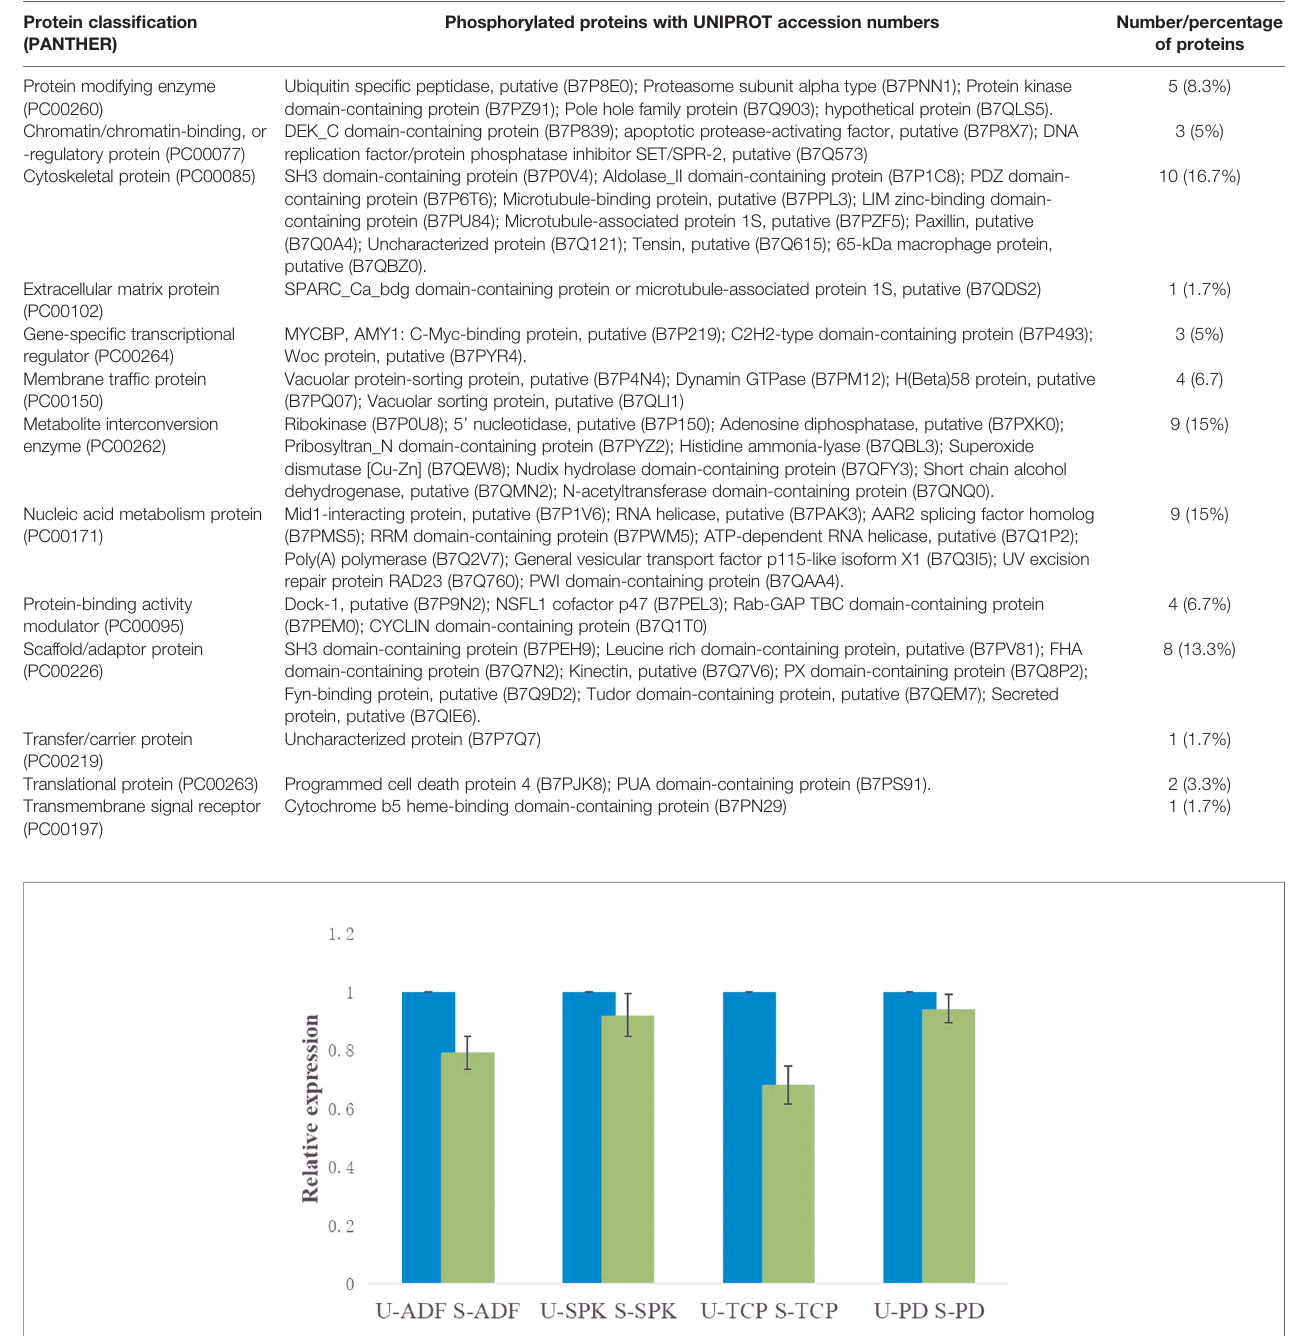
FIGURE 4 | Transcription analysis of ADF , SPK , TCP , and PD in semi-engorged ticks relative to the unfed ticks evaluated via RT-qPCR. The results are expressed as the means (n = 3) ± SEM. ADF, actin-depolymerizing factors; SPK, Serine/threonine-protein kinase; TCP, Tudor domain-containing protein; and PD, Programmed cell death protein; U-, unfed; S-,